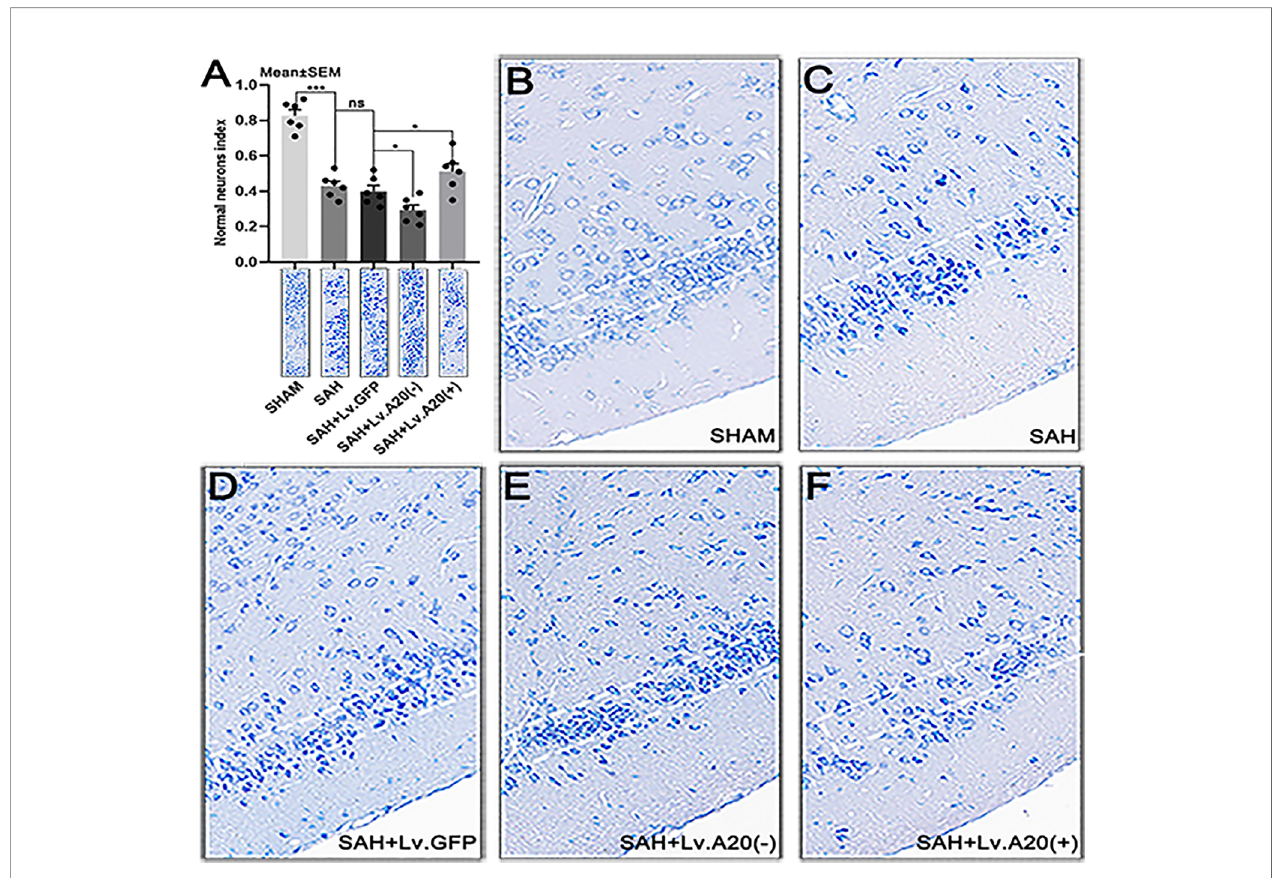
FIGURE 7 | A20 promotes neuron survival in the cortex after SAH. (A) Bar chart of the percentages of normal neurons cells in the temporal lobe cortex. (B – F) Representative images of the temporal lobe cortex. The cell body of damaged neurons was shrunken, and their nuclei stained darker compared with those of normal neurons. Data are expressed as mean ± SEM, n = 6, * p < 0.05, *** p < 0.005, ns versus SAH. ns, non-signi fi